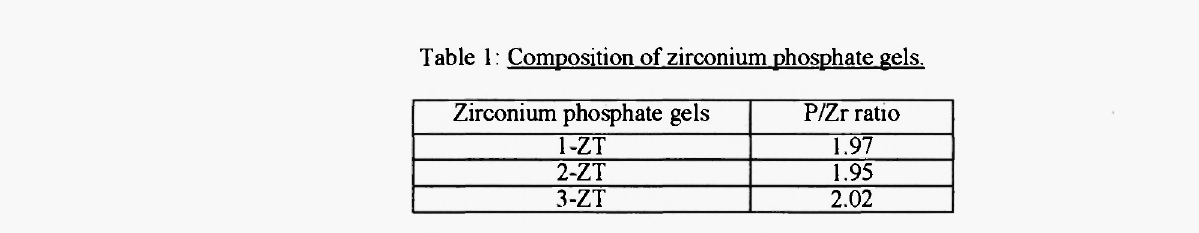
Table 1: Composition of zirconium phosphate